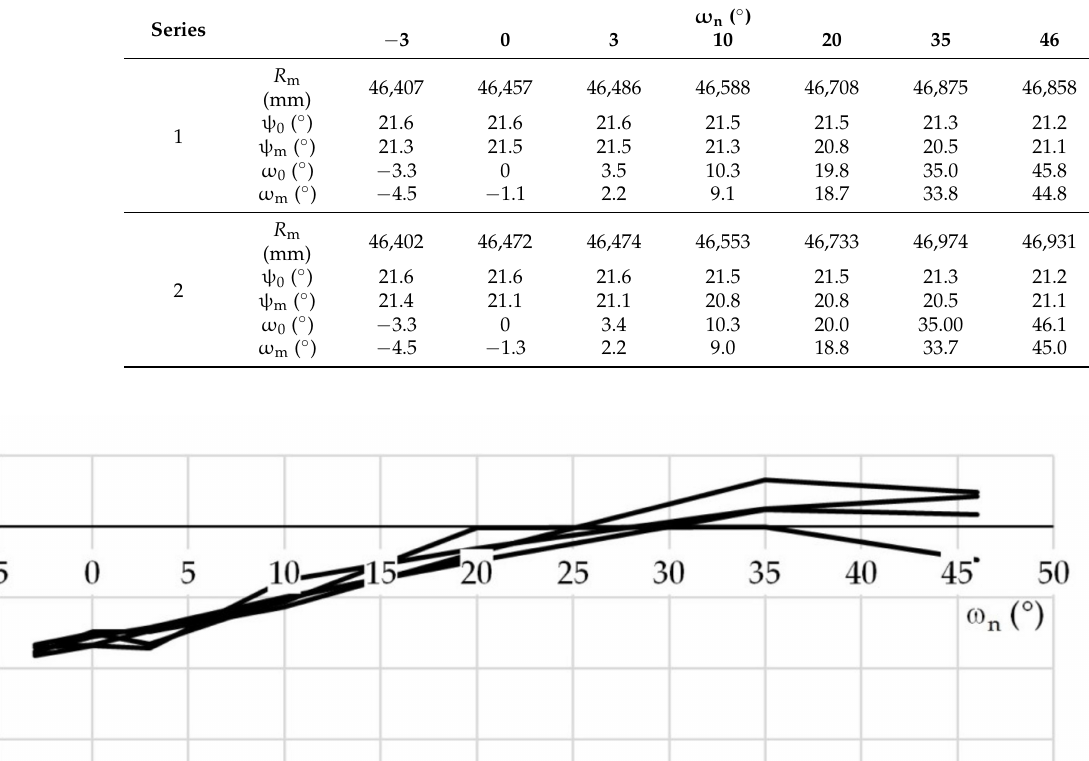
Table 1. Nominal, conventionally true, and measured beacon position coordinates; first test.